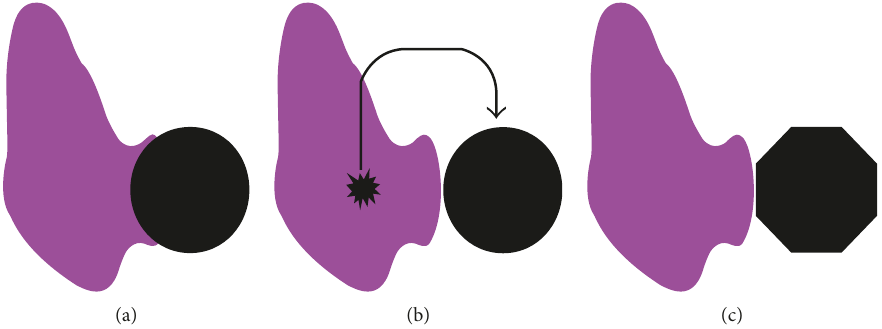
Figure 6: Three hypotheses for tumorigenesis in the present case. (a) Hypoplasia of the left thyroid lobe plus thyroid cancer occurring on the hypoplastic side, with tumor replacing the hypoplastic tissue. (b) Thyroid hemiagenesis plus thyroid microcancer plus lymph node metastasis. (c) Thyroid hemiagenesis plus ectopic thyroid on the side of the absent gland plus ectopic thyroid carcinoma.